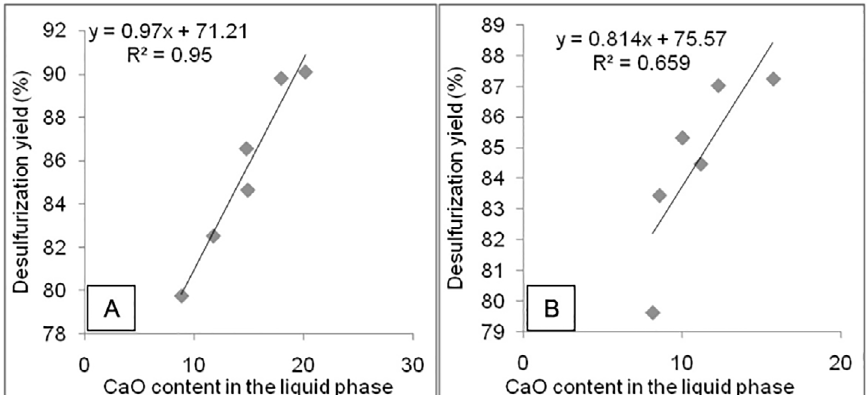
Figure 6. Relationship between liquid phase and desulfurization yield to the slags based in CaO-Al and marble waste (B).